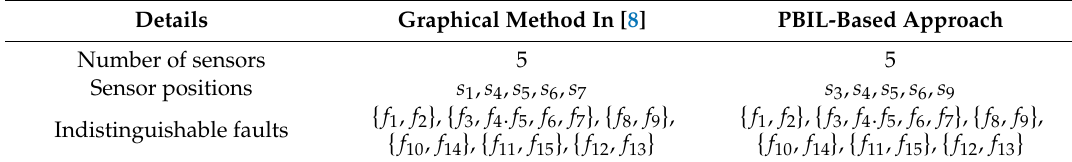
Table 6. Comparisons of the proposed approach with the approach in Reference